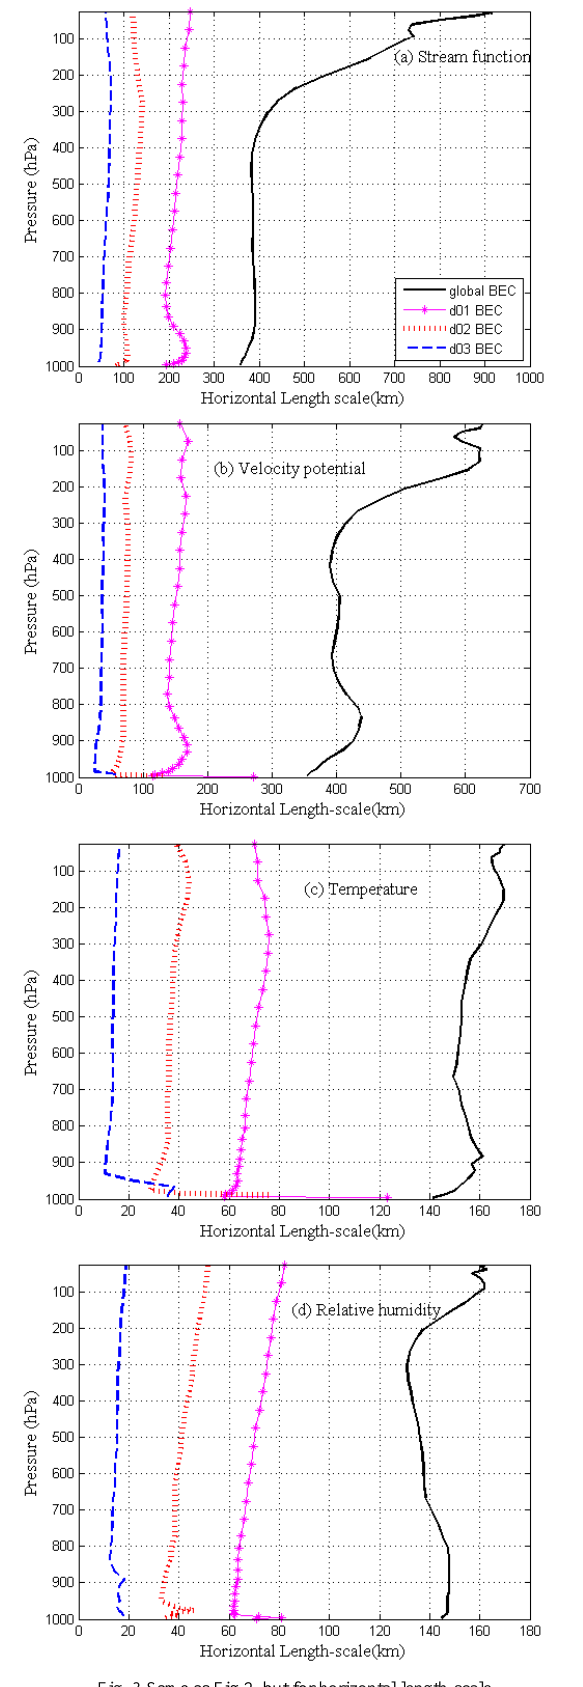
Fig. 3.Same as Fig.2, but for horizontal